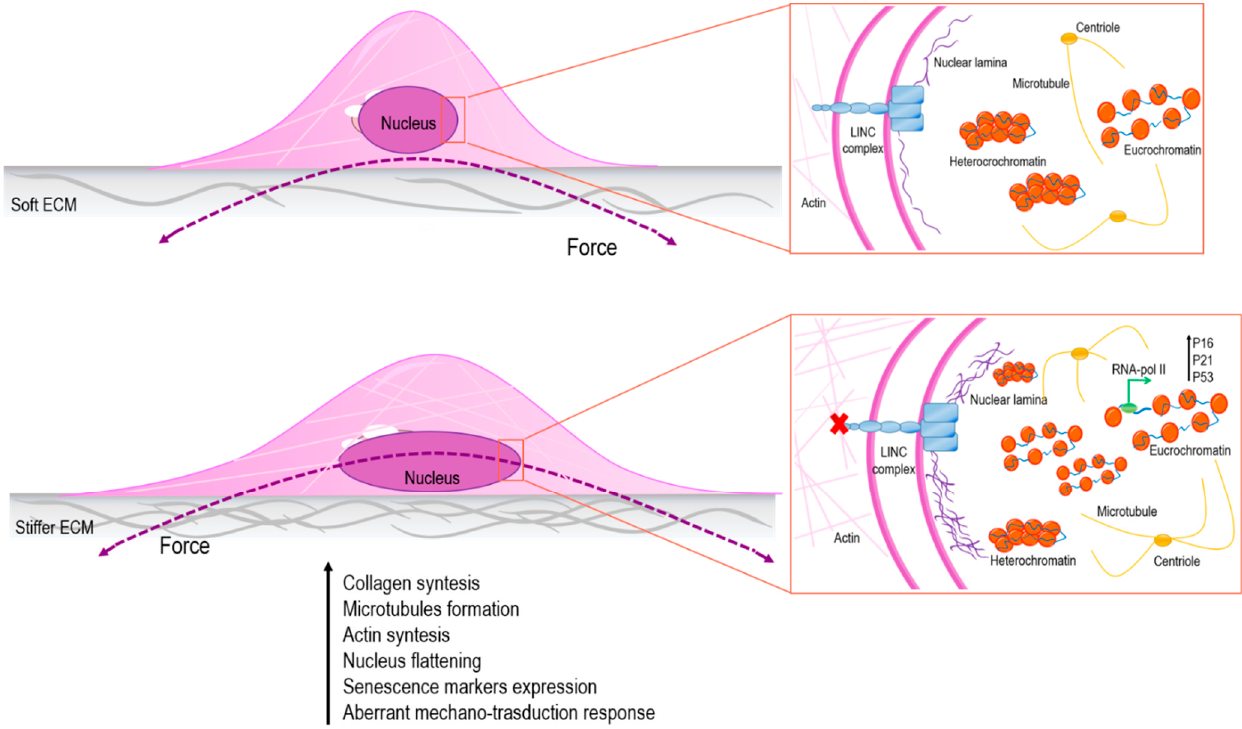
Figure 1. Stiffness of the nucleus affects structure and organization of chromatin with consequences on gene transcription. In particular, in the presence of soft extracellular matrix (ECM), the cell nucleus is subject to low straining forces and the amount of heterochromatin is higher than euchromatin; on the other hand, in presence of stiffer ECM, the cell nucleus is stretched, and, as a result, chromatin changes its status into a more relaxed conformation, promoting senescence markers’ expression [59–61]. Table 1. Histone modification patterns in association with aging.